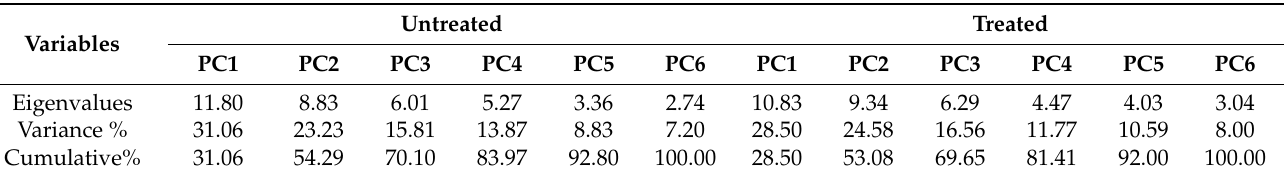
Table 4. PCA results of the six PCs for the investigated variables under study for both untreated and treated palm date types using SDBD plasma.